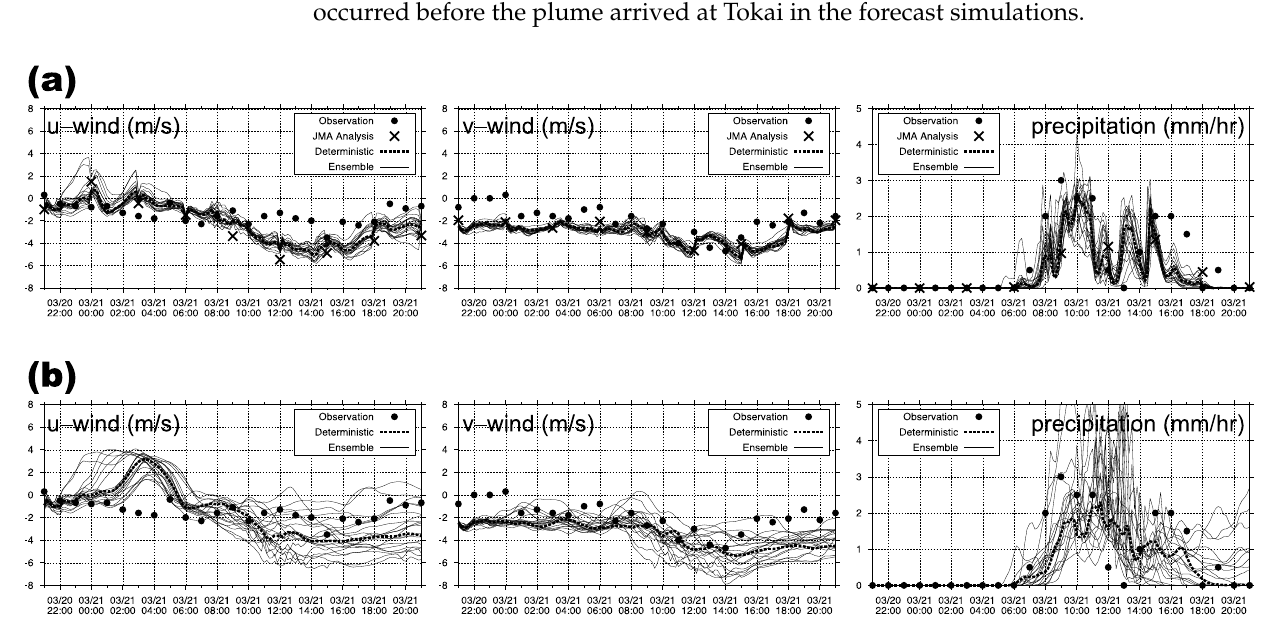
Figure 5. Same as Figure 2 but for the time period from 21:00 20 March to 21:00 21 March local time. The forecasts were initiated at 21:00 20 March local time.